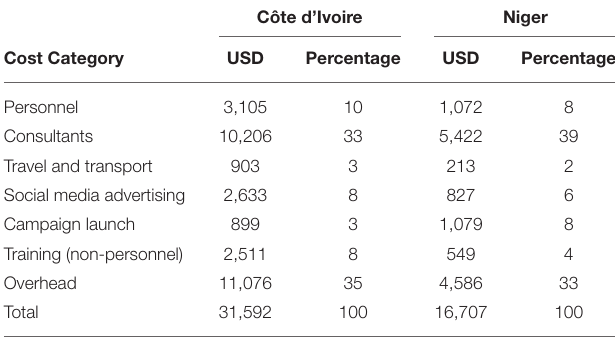
TABLE 2 | Total design, production, and dissemination costs.